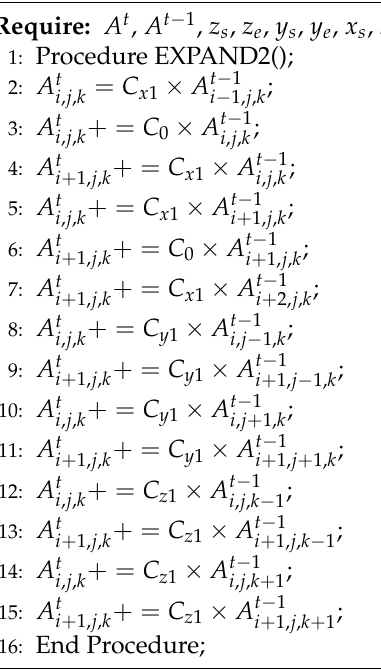
Algorithm 8 Continue to expand the formula in Algorithm 7